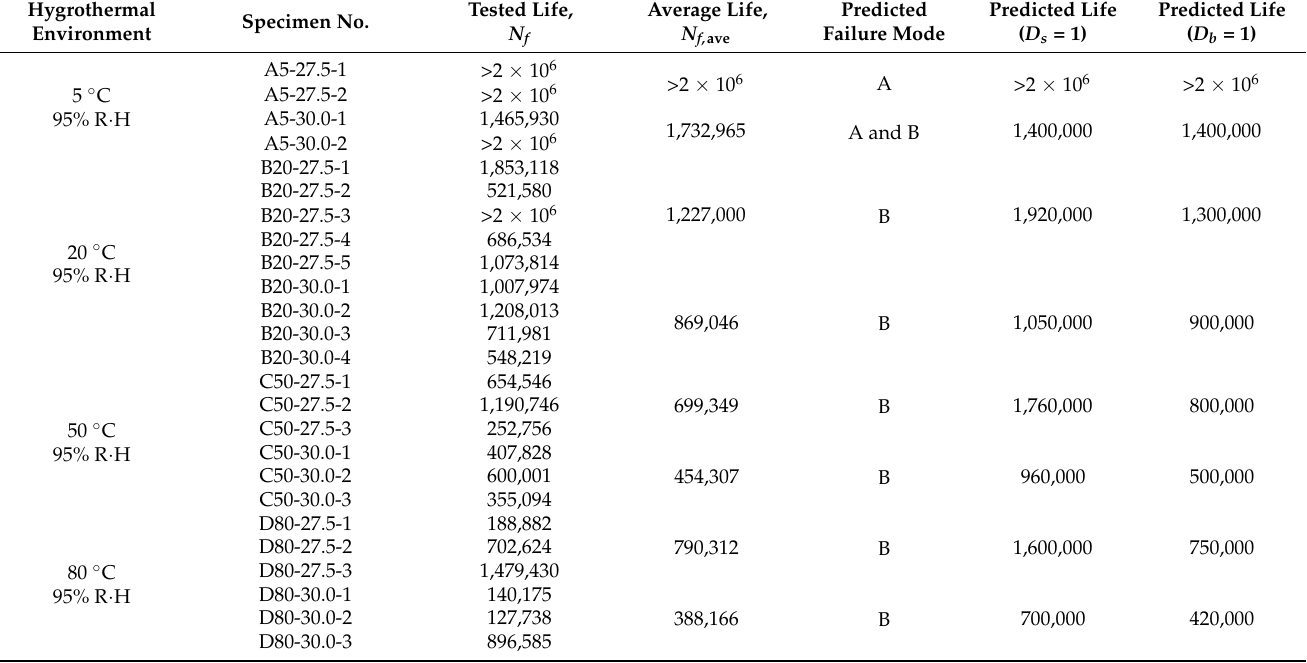
Table 4. Detailed test information and prediction